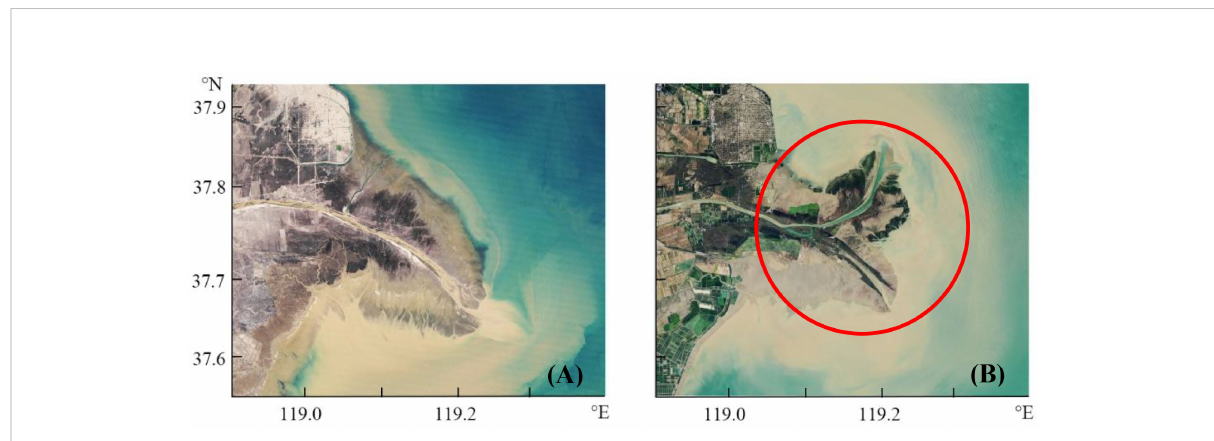
FIGURE 1 Landsat satellite images of the YRD in 1989 (A) and 2015 (B) .